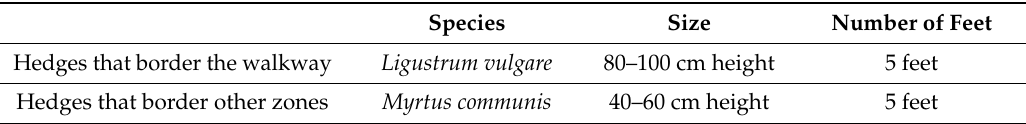
Table 6. Species selected for planting and border hedges for Zone J.